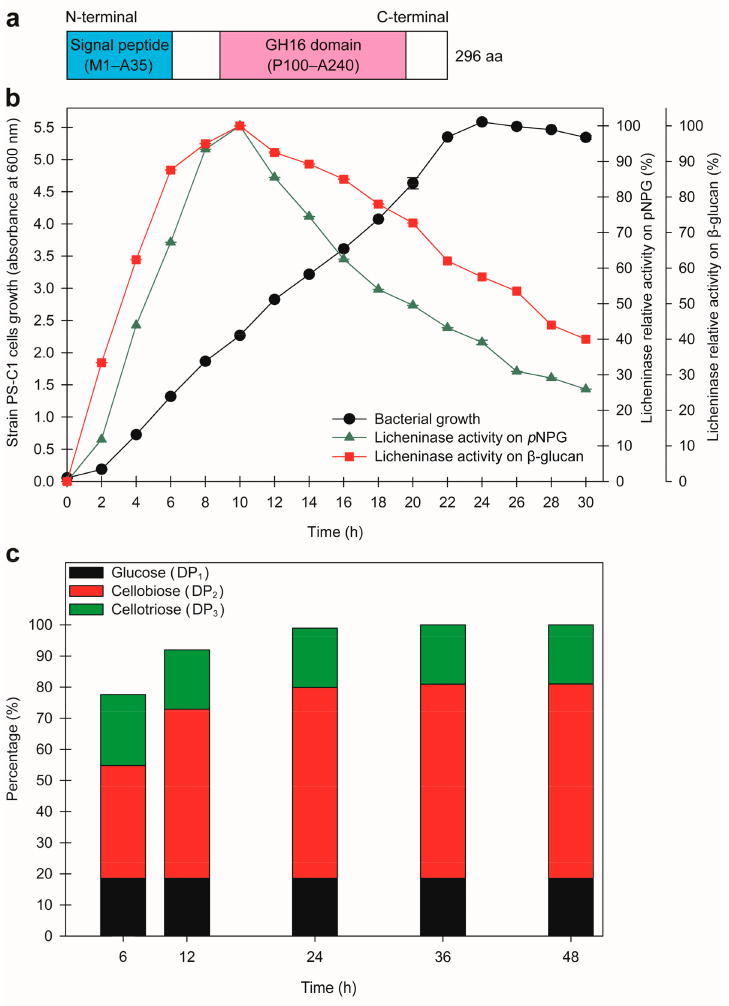
Figure 5. ( a ) Schematic representation of domain arrangements for the licheninase from strain PS-C1 (LicPS-C1); aa: amino acids. ( b ) Time courses of strain PS-C1 growth and LicPS-C1 production by cultivation in the marine broth supplemented with 1% ( w / v ) cellobiose. The LicPS-C1 activities were detected using p -nitrophenyl- β -D-glucopyranoside ( p NPG) and β -glucan as the enzymatic substrates. The values shown represent the mean ± standard error of triplicate analyses. ( c ) Analysis of reaction products produced by LicPS-C1 acting on β -glucan at different time intervals using ultra-high- performance liquid chromatography with an evaporative light-scattering detector (UHPLC-ELSD). The amount of total sugars produced at each time point is shown relative to that at 48 h. Dp 1 : glucose; Dp 2 : cellobiose; Dp 3 :